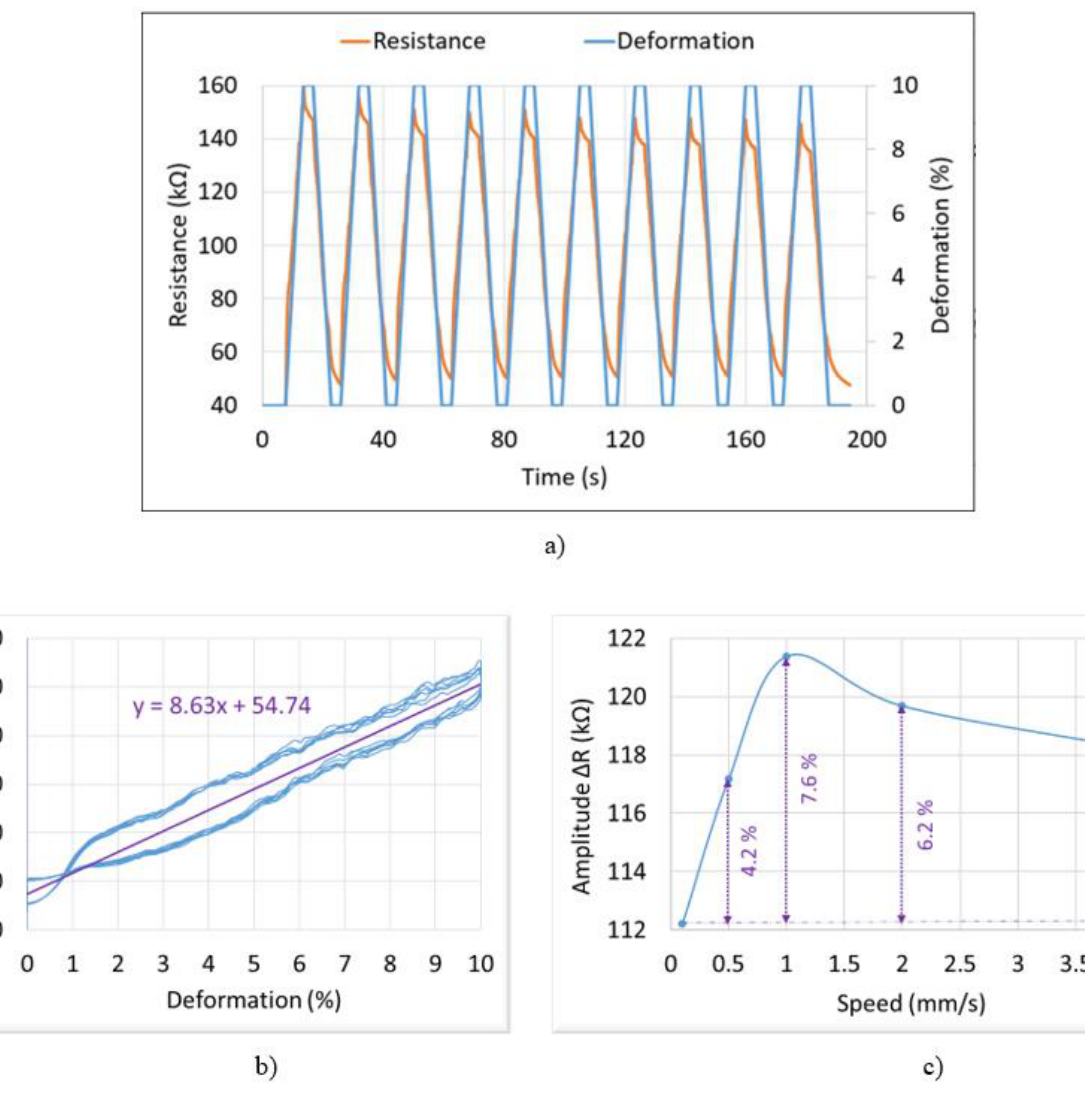
Figure 10. Behavior of the first ink based on tensile tests: ( a ) time evolution of resistance (red) and deformation (blue), ( b ) resistance vs. deformation, ( c ) resistance variation ( ∆ R) vs. speed at a 10% deformation.